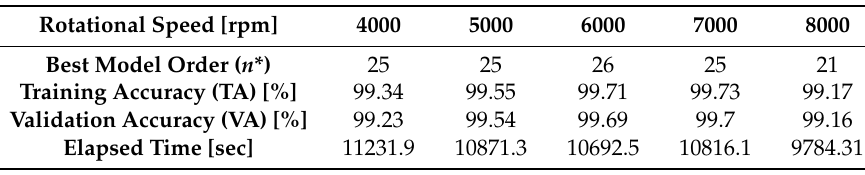
Table 5. Results of 2-fold cross validation at a given rotational speeds.